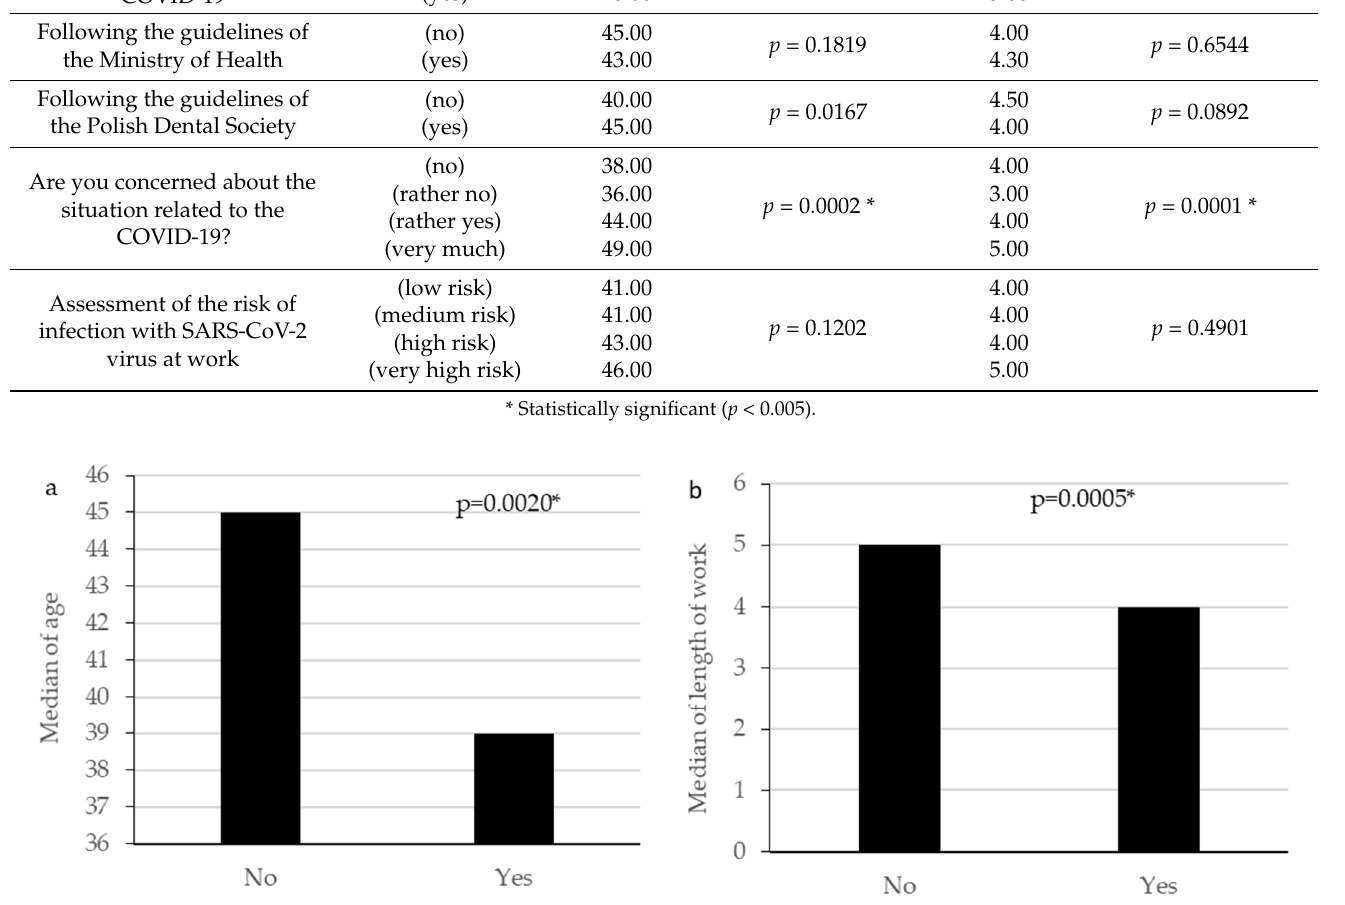
Figure 2. Feeling anxious about the situation related to the COVID-19 pandemic among general dental practitioner and specialists (* significant difference at p < 0.05 by way of the Chi square test). 4. Discussion and Additional Results There are several additional discoveries revealed by our study. These concern ques- tions of knowledge, behavior, and adjustments made by dentists in the early stage of the pandemic. Up-to-date and reliable knowledge about the SARS-CoV-2 coronavirus allow 0%5% 10%15% 20%25%